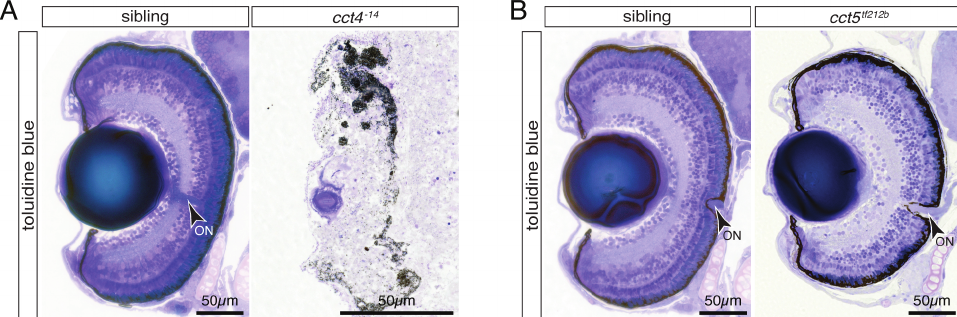
Figure 1. The eye develops in cct5 𝑡𝑓121𝑏 but not cct4 −14 mutants. (A) Toluidine Blue-stained sections of six-dpf-old siblings revealed the typical layered structure of the retina. In contrast, the eye of TRiC loss-of-function cct4 −14 mutants was severely degraded and only rudimentary structures of lens and pigmented retina were recognisable. (B) At six dpf, homozygotes of the missense mutant cct5 𝑡𝑓212𝑏 featured a structured eye and the layering of the retina appeared comparable to siblings. Arrowheads indicate optic nerves (ON).